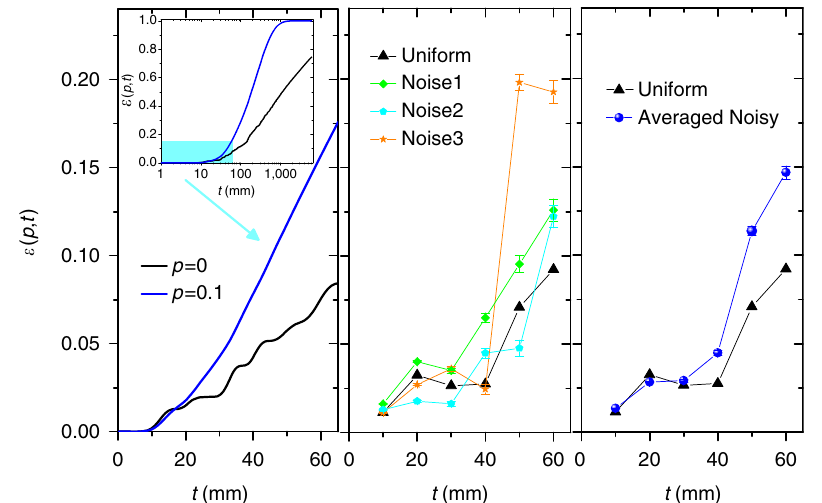
Figure 4 | Role of noise in the transfer efficiency time evolution. Left: Theoretical behaviour of the transfer efficiency E p ; t ð Þ as a function of the evolution parameter t for two values of the mixing parameter p , corresponding to QW ( p ¼ 0) and QSW ( p ¼ 0.1), for the maze in Fig. 3. Inset: a larger time scale is shown in order to point out the remarkable efficiency enhancement when there is a partial suppression of interference. Centre: Experimental results for both uniform (triangles) and three noisy realizations of the structure reported in Fig. 3. Where not shown the error bars are smaller than the mark size. Right: as in the middle panel, but only with the uniform case (triangles) and with the average efficiency over the noise realizations (circles). In all three panels, the time t is in units of mm because it is experimentally mapped into the propagation length of the three-dimensional waveguide array.